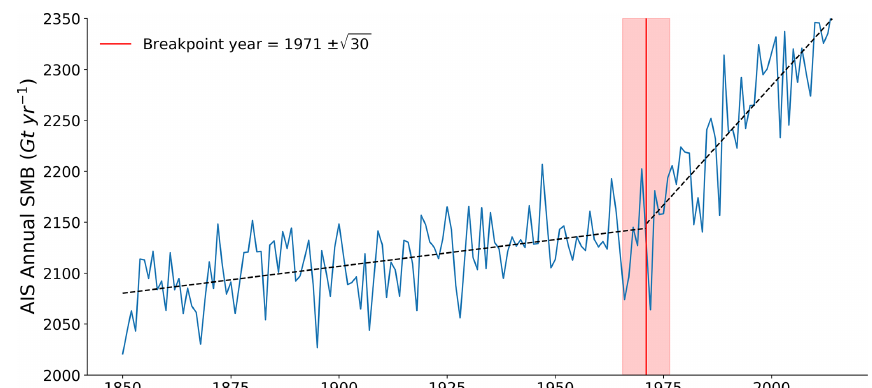
Figure A6. SMB breakpoint year, indicating the year with the greatest SMB change between preceding and subsequent 30-year periods. Uncertainty, shaded in red, is defined as